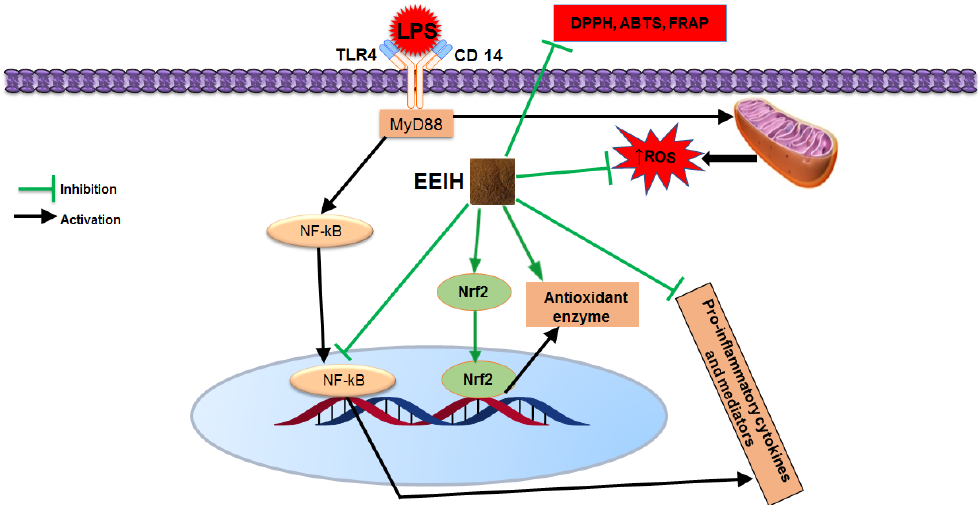
Figure 8. A proposed schematic diagram illustrating the mechanism of protection of EEIH against LPS-induced acute liver injury. EEIH: ethanol extract of Illicium henry , LPS: lipopolysaccharide, DPPH: 2,2-diphenyl-1-picrylhydrazil, ABTS: 2,2′-azino-bis-(3-ethylbenzothiozoline-6-sulfonic acid) disodium salt, FRAP: ferric-reducing antioxidant power, ROS: reactive oxygen species, TLR4: toll-like receptor 4, NF-κB: nuclear factor-κB, Nrf2: nuclear factor erythroid 2-related factor 2.